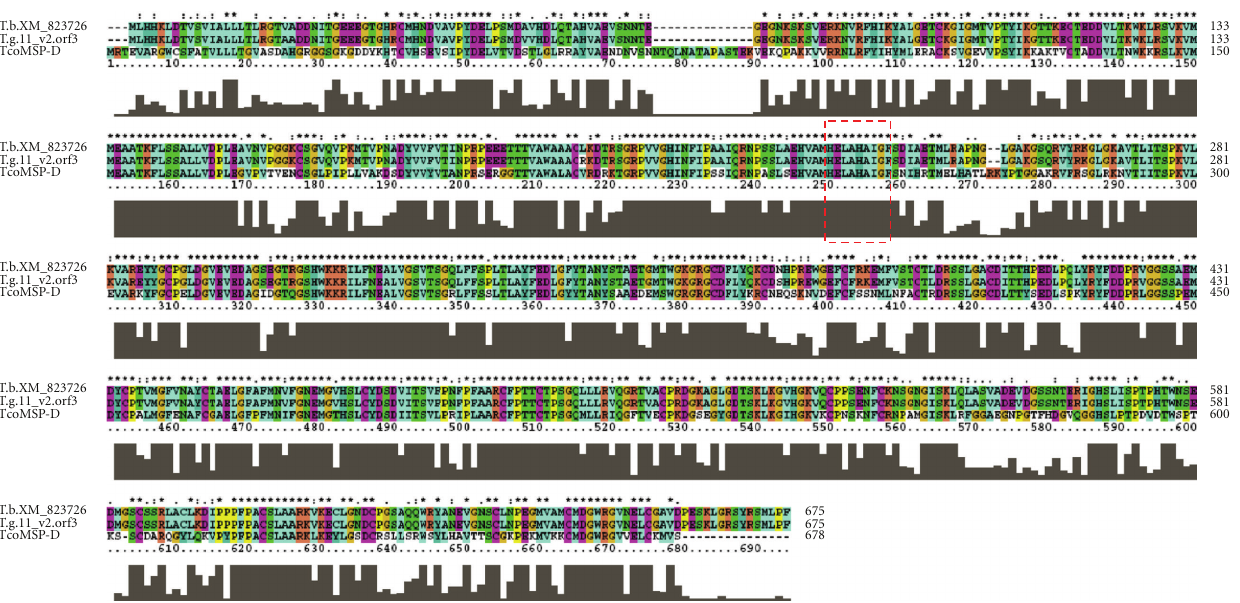
Figure 4: Multiple sequence alignment of MSP putative functional homologues: and T. congolense TcoMSP-D, T. brucei TREU927 XM 823726, T. gambiense chromosome 11 MSP ORF3. The predicted amino acid sequences for each homologue were aligned using the ClustalW alignment tool. Output was directly generated using ClustalX for Windows. The dashed red box indicates a conserved motif shown to be essential for Zn 2+ binding in related